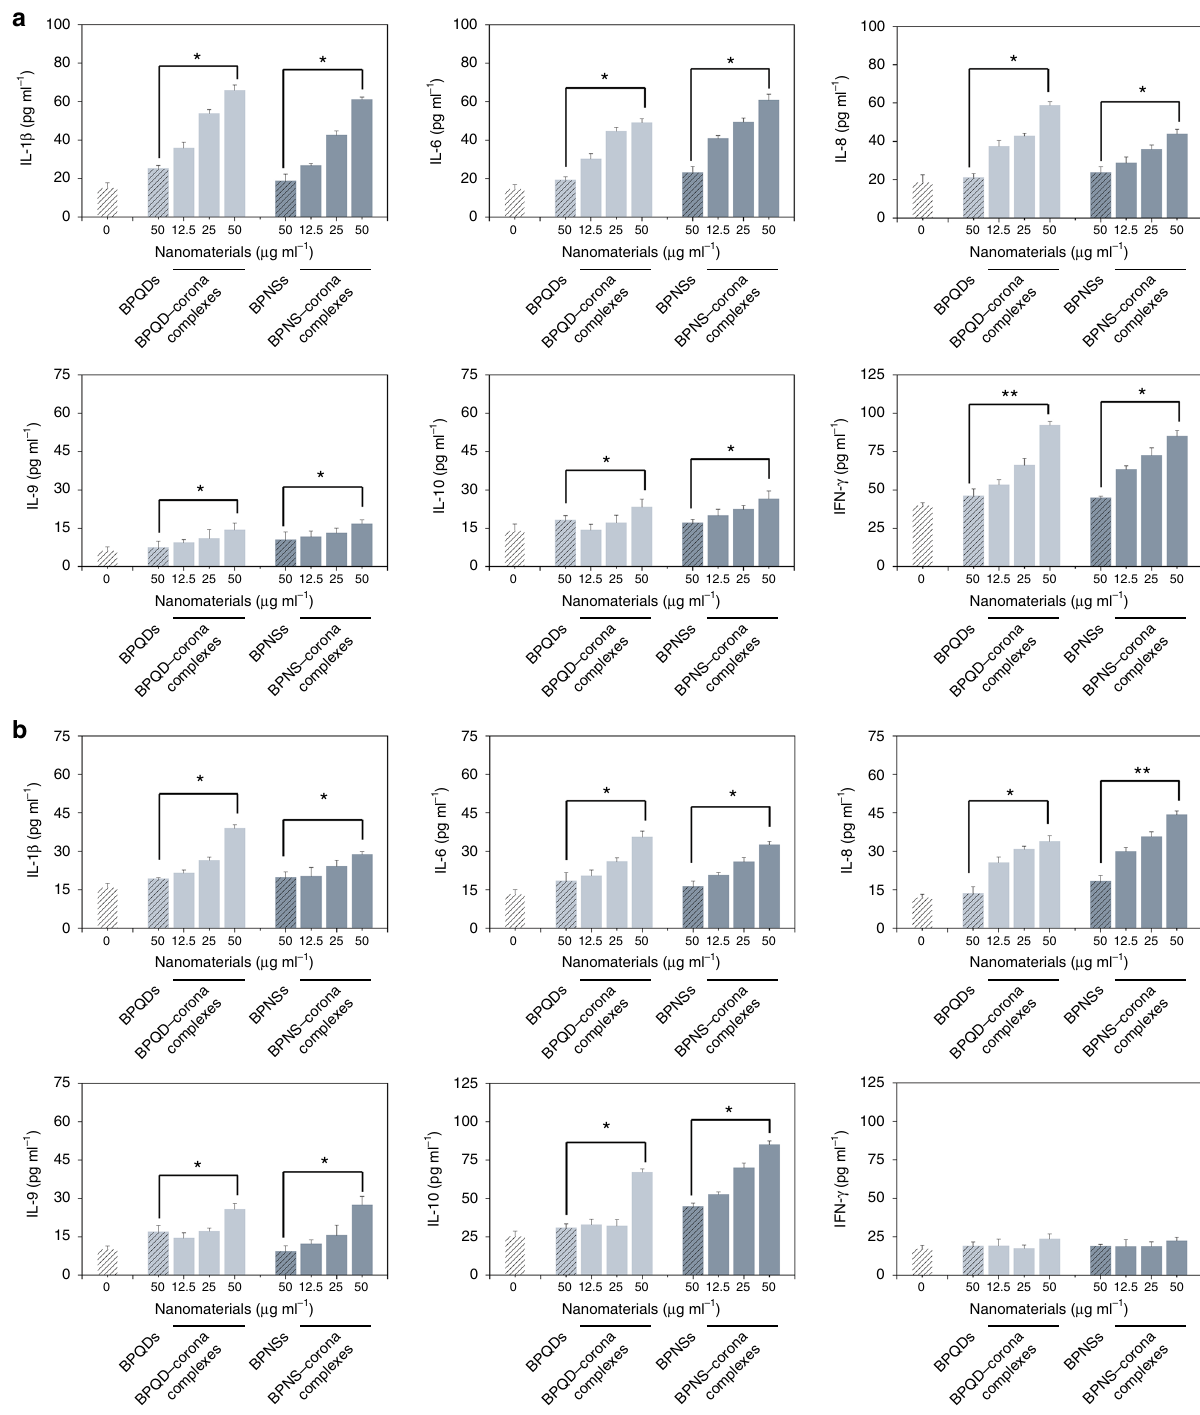
Fig. 5 Cytokine secretion of different macrophages. Macrophage-like dTHP − 1 cells ( a ) or SC cells ( b ) were treated with 50 μ g ml − 1 BP nanomaterials and an increasing concentration of corona complexes (12.5, 25 and 50 μ g ml − 1 ) for 6 h. Values are expressed as the means ± SDs of triplicates. Statistical signi fi cance is assessed by Student ’ s t test. * p < 0.05, ** p <